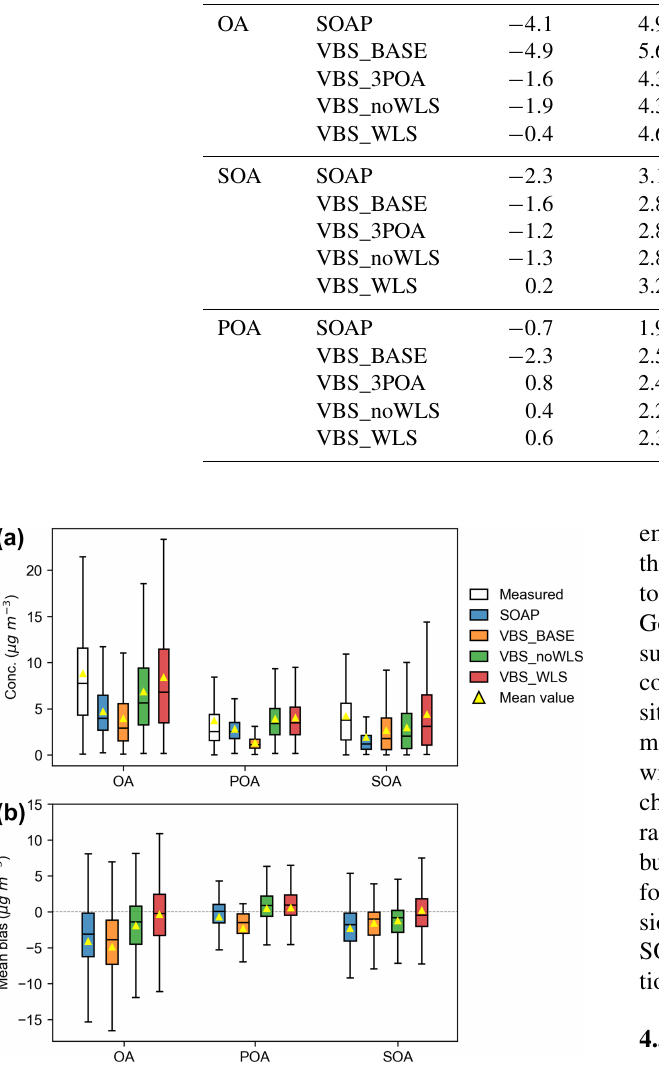
Figure 4. Concentrations of measured and modeled OA, POA, and SOA at five ACSM or AMS stations in winter (a) and mean bias for different OA schemes (b) . The lines inside boxes represent median values, and the yellow triangles represent mean values.